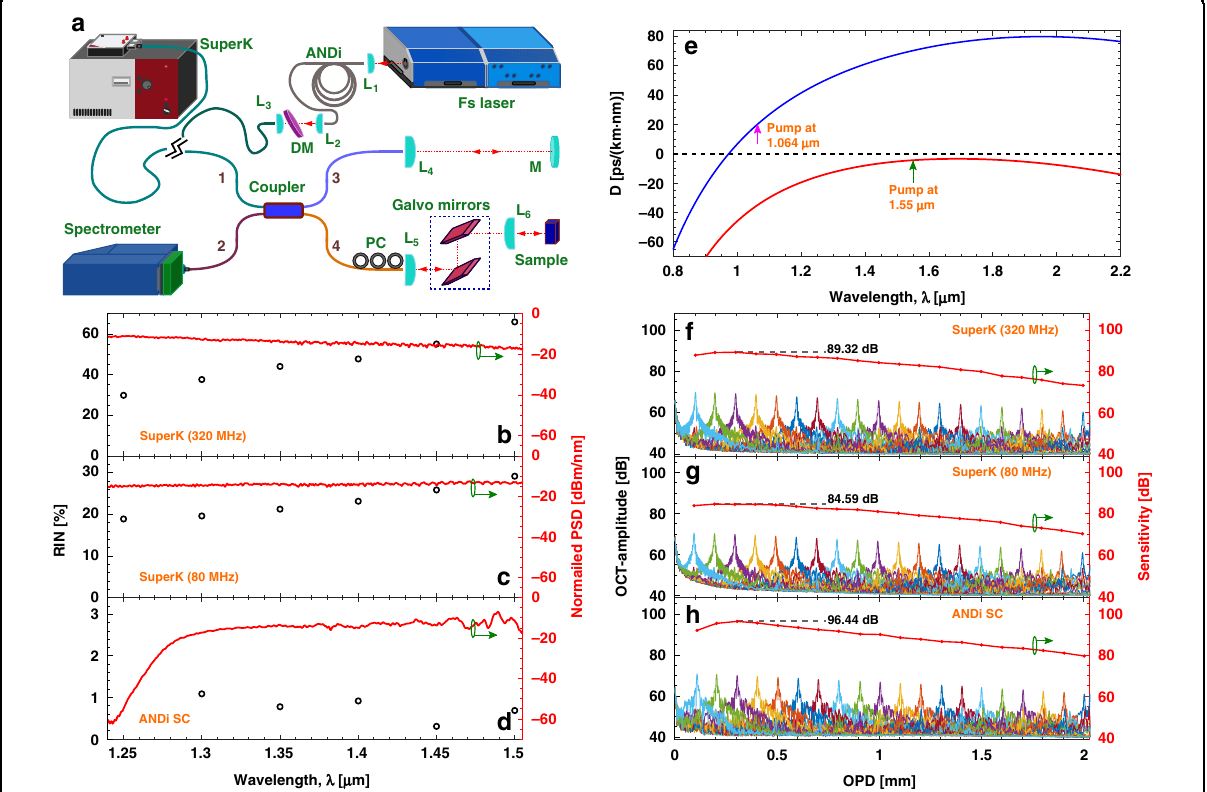
Fig. 6 OCT system and SC source characterization. Schematic of the OCT setup ( a ) [L i lens, M mirror, DM dichroic mirror, and PC polarization controller]. Normalized power spectral density (PSD) pro fi les measured using an OSA (red curves, right axis) and RIN pro fi les (black circles, left axis) for the 320 MHz SuperK extreme ( b ), the 80 MHz SuperK extreme ( c ), and the ANDi based low-noise SC source ( d ). Calculated dispersion pro fi le for the nonlinear fi ber used in the SuperK extreme (blue) and the measured dispersion of the GeO 2 doped silica ANDi fi ber (red) ( e ). Mean OCT-amplitude (over 1024 measurements) of a sample mirror at 20 different axial positions on the left axis, and the sensitivity on the right, for the SuperK extreme at 320 MHz ( f ) and 80 MHz ( g ), and the ANDi based low-noise SC source ( h